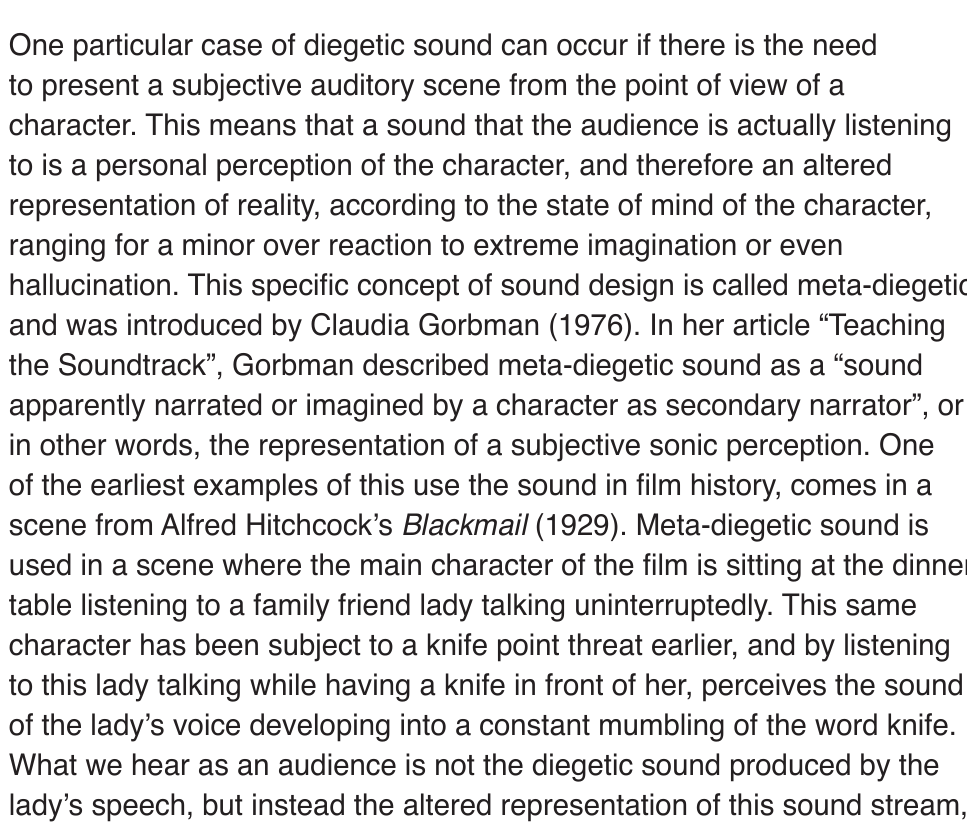
Figure 4: Transitioning from diegetic to non-diegetic in Mel Brooks’ High Anxiety